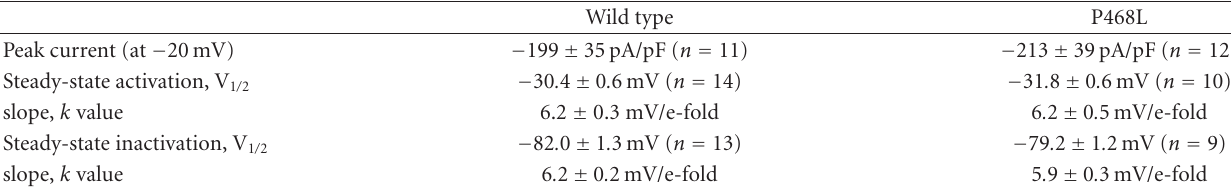
Table 1: Kinetic parameters of wild type and P468L current measured in transiently transfected HEK-293